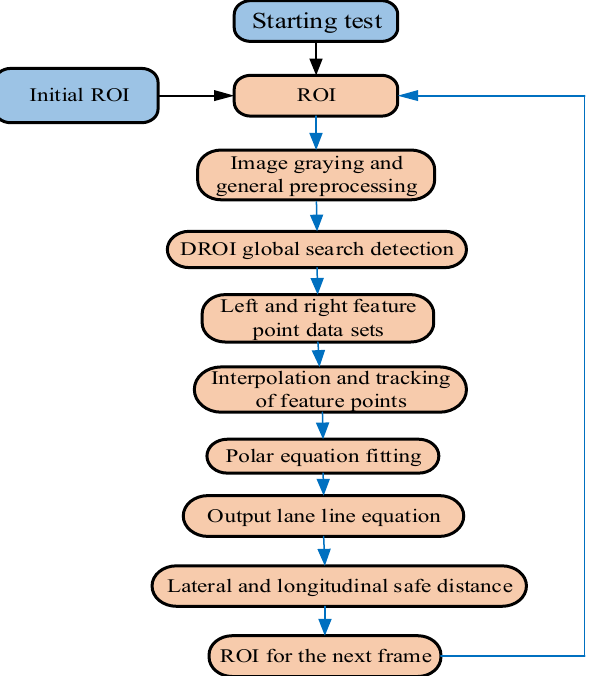
Figure 12. Flow chart of the proposed lane line detection algorithm.